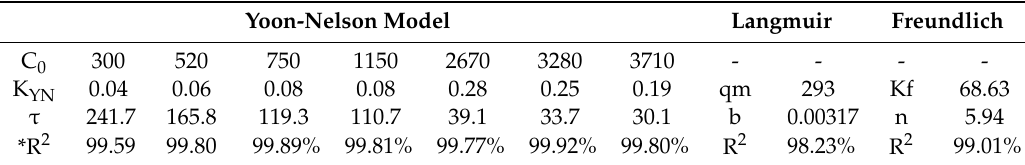
Table 2. Y-N model and isotherms parameters for p-xylene adsorption on AC-Si-0.2-0.3. Table 1. Y-N model and isotherms parameters for p-xylene adsorption on AC-Si-0.2-0.3. Yoon-Nelson Model Yoon-Nelson model Langmuir